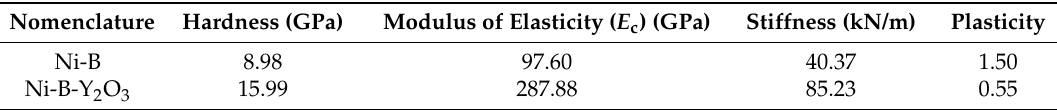
Figure 7. The potentiodynamic curve for steel substrate is included for comparison.